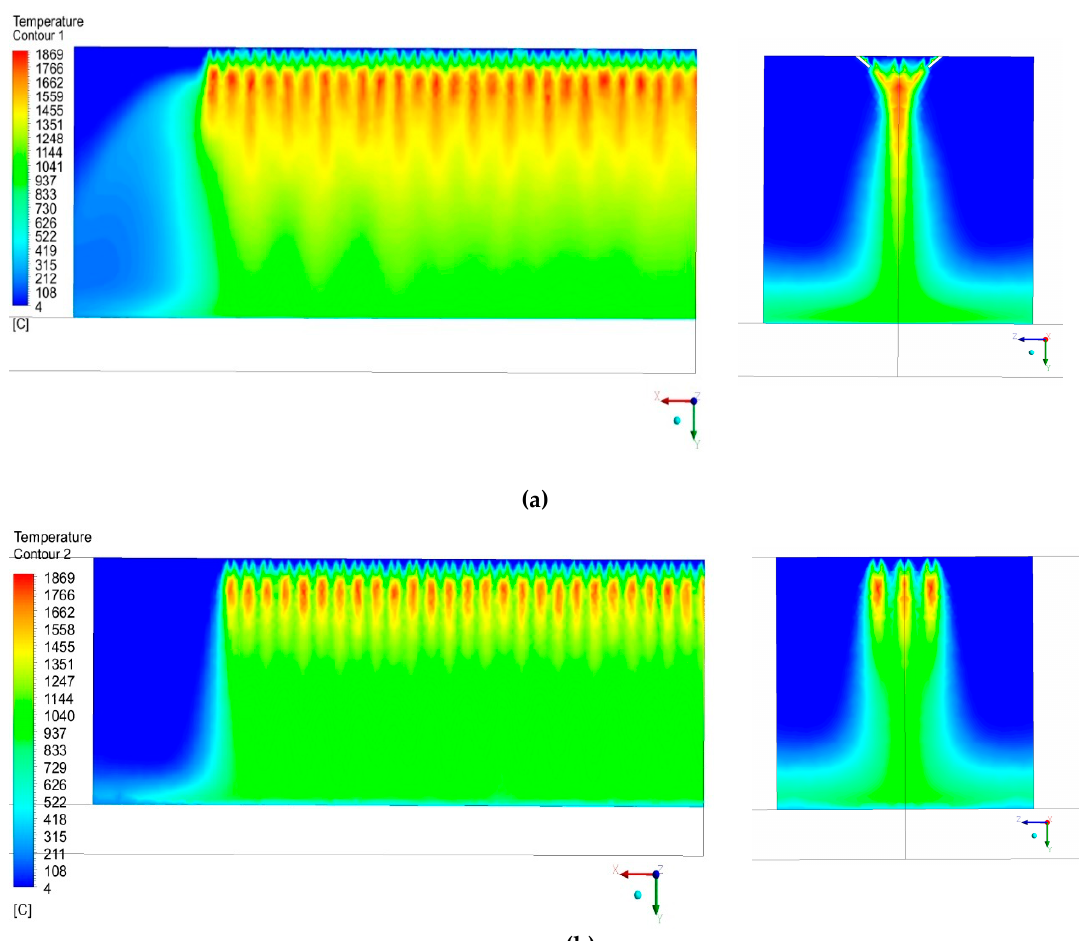
Figure 7. Temperature contours from the gas torch outlets to the steel plate at the center view (left) and side view (right) section when preheating the steel plate at Φ = 1, Re = 3483, and Y/d = 50: ( a ) With guide vanes; ( b ) without guide vanes.